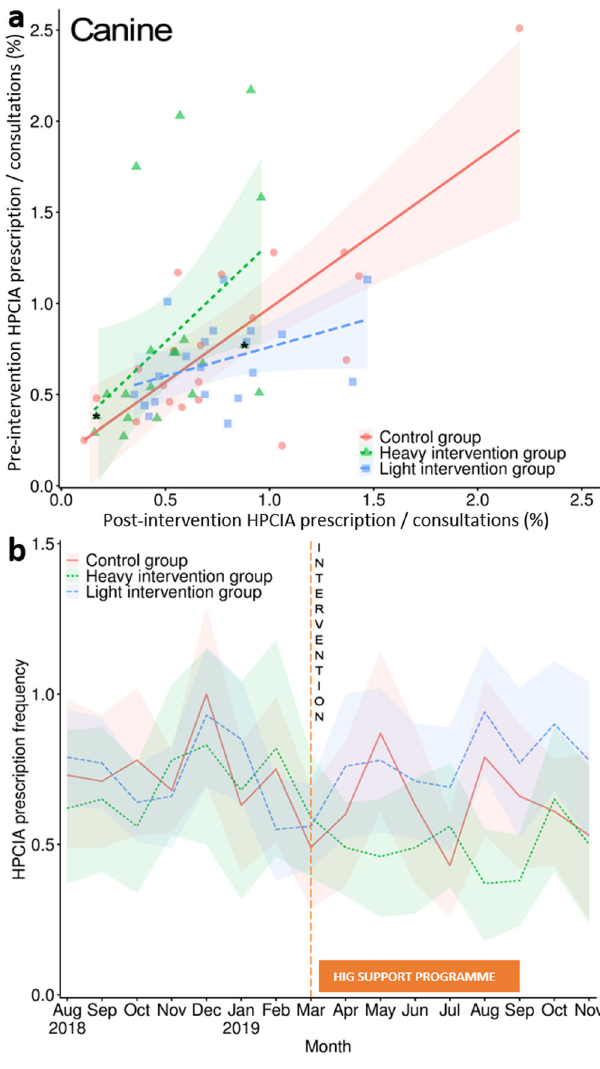
Fig. 2 Canine highest priority critically important antimicrobial prescription frequency. Canine highest priority critically important antimicrobial (HPCIA) prescription frequency as a percentage of total consultations, measured by ( a ) practice pre-intervention (August 2018 – March 2019 inclusive) and post-intervention (April – November 2019 inclusive), and ( b ) month. Lines in plot a refer to linear regression fi ts, modelling intervention status by practice, with lines referring to regression fi t estimates around a 95% con fi dence interval (shaded region). An asterisk refers to the two practices in the HIG which declined to participate in the post-benchmarking intervention re fl ection and education programme. Lines in plot b refer to HPCIA prescription frequency as a percentage of total consultations; the red solid line in both plots a and b refers to fi ndings from the control group (CG); the blue hashed line refers to the light intervention group (LIG), and the green dotted line refers to the heavy intervention group (HIG). The orange dashed line in plot b shows the month at which the initial noti fi cation took place, and the orange solid box outlines the months in which the HIG could access further support if requested. Shaded regions refer to 95% con fi dence intervals. Data is derived from 88,298 pre- intervention and 81,582 post-intervention CG consultations; 107,223 pre- intervention and 105,518 post-intervention LIG consultations, and 63,366 pre-intervention and 63,301 post-intervention HIG consultations.